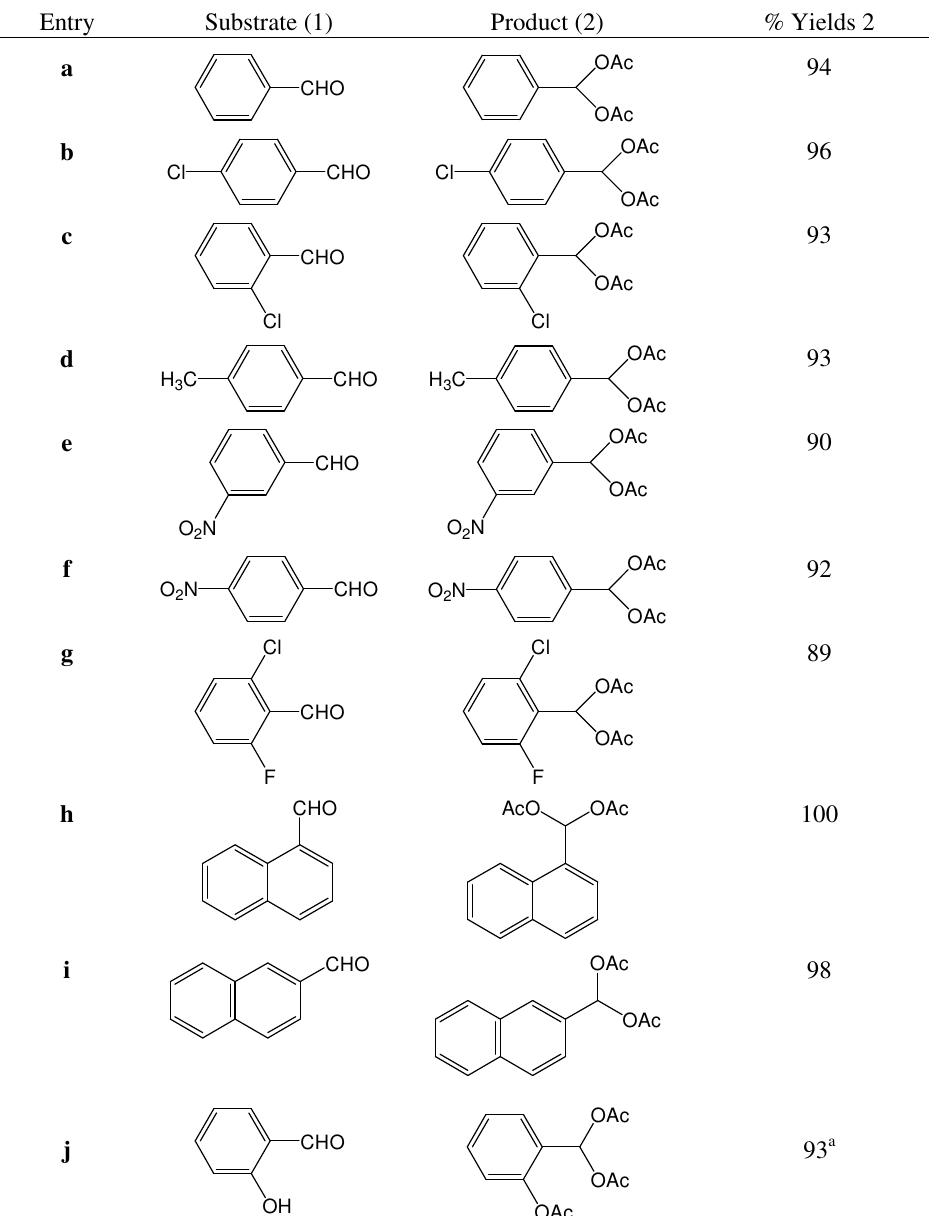
Table 1 Preparation of various 1,1-diacetates 2 from the corresponding aldehydes 1 using H PAlMo AlO as catalyst 6 11 40